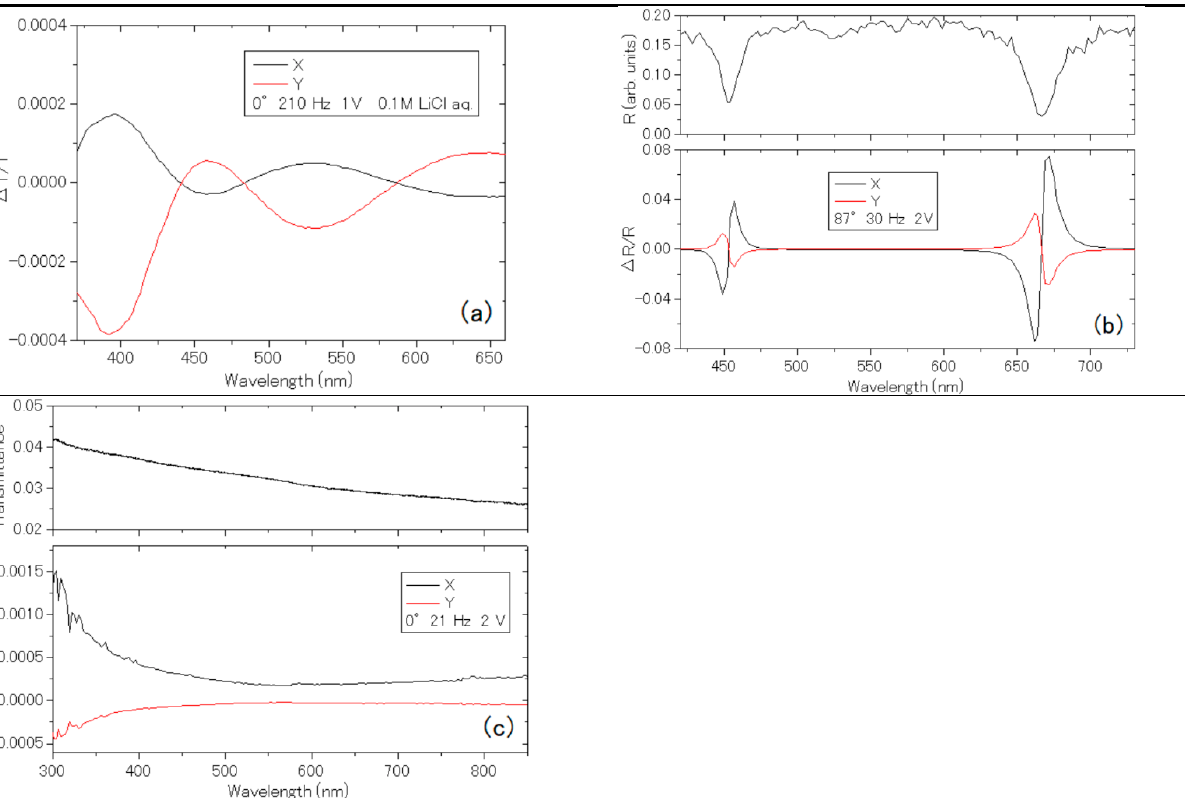
Figure 11. ( a )Typical data for raw electromodulation transmission change spectra of normal incidence on 330-nm thick Indium Tin Oxide (ITO) electrode in 0.1 M LiCl aqueous solution with an AC voltage of 1 V (ampliude) at 210 Hz. The 𝑋 signal is due to blue shift of the transmission spectrum. ( b ) Raw electromodulation reflection change spectra of 87° incidence on 400-nm thick TCO electrode in 0.1 M NaCl aqueous solution with an AC voltage of 2 V (ampliude) at 30 Hz. The 𝑋 signal is due to blue shift of the reflection spectrum [21]. ( c ) Raw electromodulation transmission change spectra of normal incidence on 20-nm thick Pt electrode in 0.1 M NaCl aqueous solution with an AC voltage of 2 V (ampliude) at 21 Hz. The 𝑋 signal is characterized by red shift of the transmission spectrum [8].